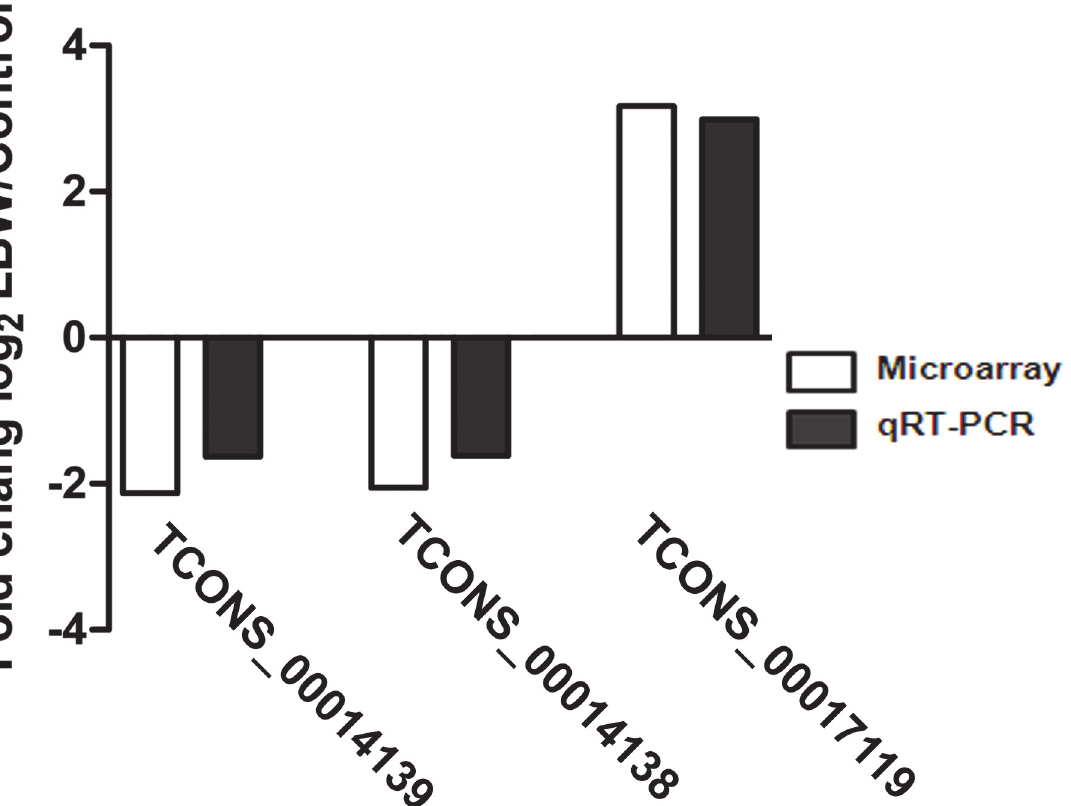
Fig 3. Comparison of microarray and quantitative real-time PCR data for differentially expressed lncRNAs. The qRT-PCR results (n = 7) in three lncRNAs are consistent with the microarray data in the kidney obtained at postnatal day 10. The qRT-PCR reactions were repeated three times for every lncRNA. The level of lncRNA was calculated relative to GAPDH. The data are expressed as the log-transformed mean fold changes (Low birth weight/ Control).